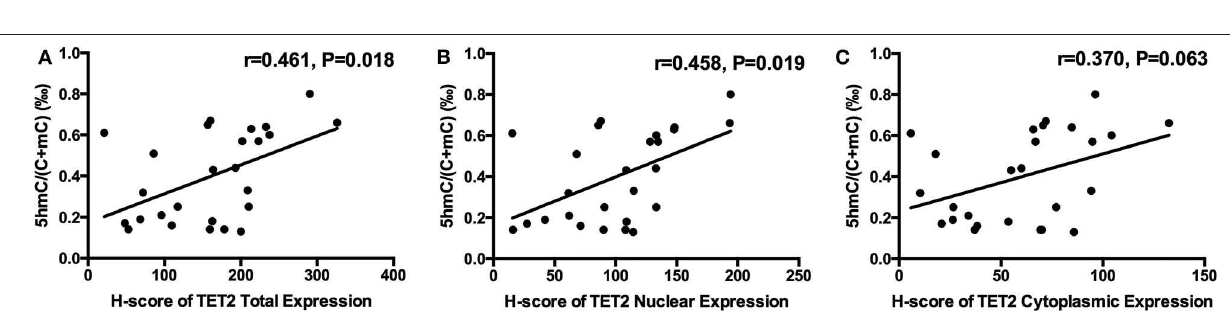
FIGURE 4 | Relation between NFPA genomic 5hmC and TET2 expression and localization. (A) NFPA genomic 5hmC levels were positively related with TET2 total expression. (B) NFPA genomic 5hmC levels were also positively related with TET2 nuclear expression. (C) NFPA genomic 5hmC levels were not significantly related with TET2 cytoplasmic